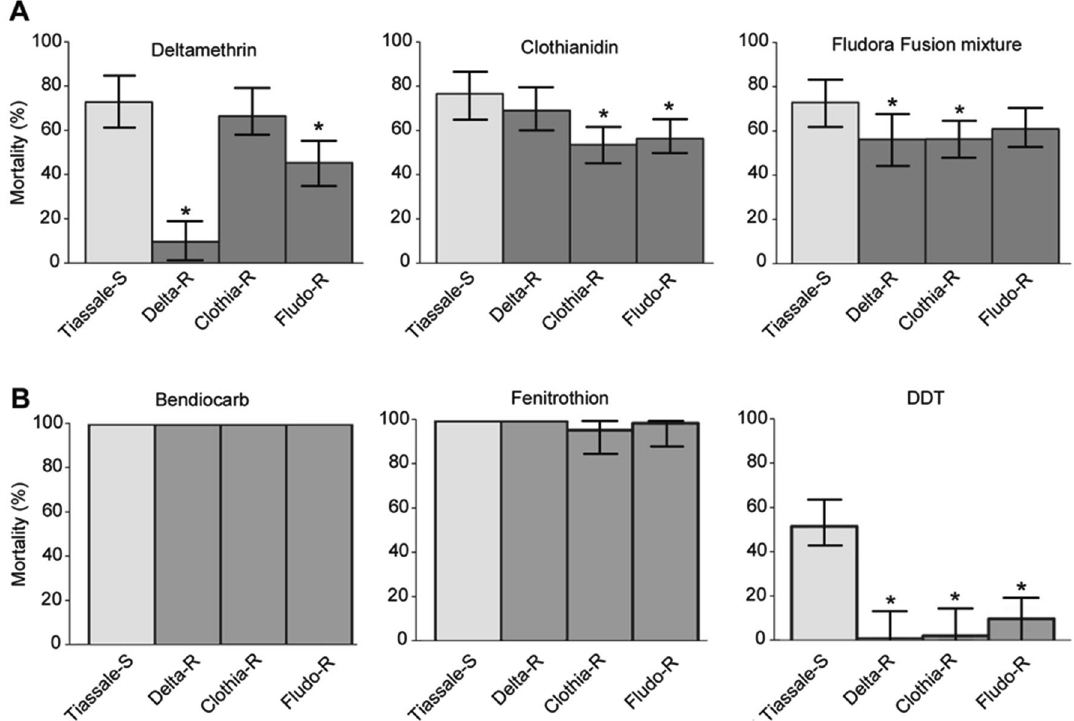
Figure 2. Cross-resistance of each line to insecticides. Cross-resistance profiles of each line to insecticides used for selection ( A ) and to other insecticide families used for vector control ( B ). All lines were compared at generation G17. Resistance levels to the insecticides used for selection were compared using bottle assays while resistance levels to other insecticides were compared using WHO test tubes equipped with papers impregnated with 0.5% bendiocarb, 1% fenitrothion and 4% DDT. Mortality rates are expressed as mean % mortality ± 95% Wald confidence interval and were compared to the unselected line using a Fisher test on mortality proportions (*p < 0.05).